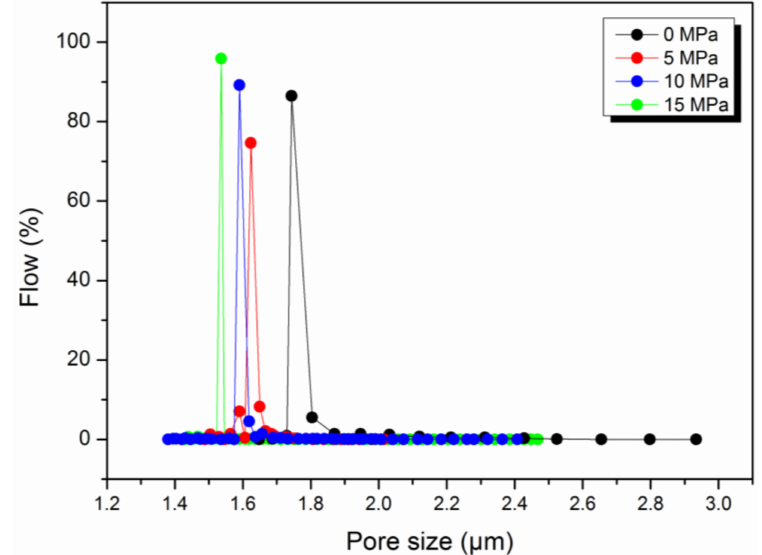
Figure 4. Pore size distribution of composite HNM under different pressures in hot pressing.